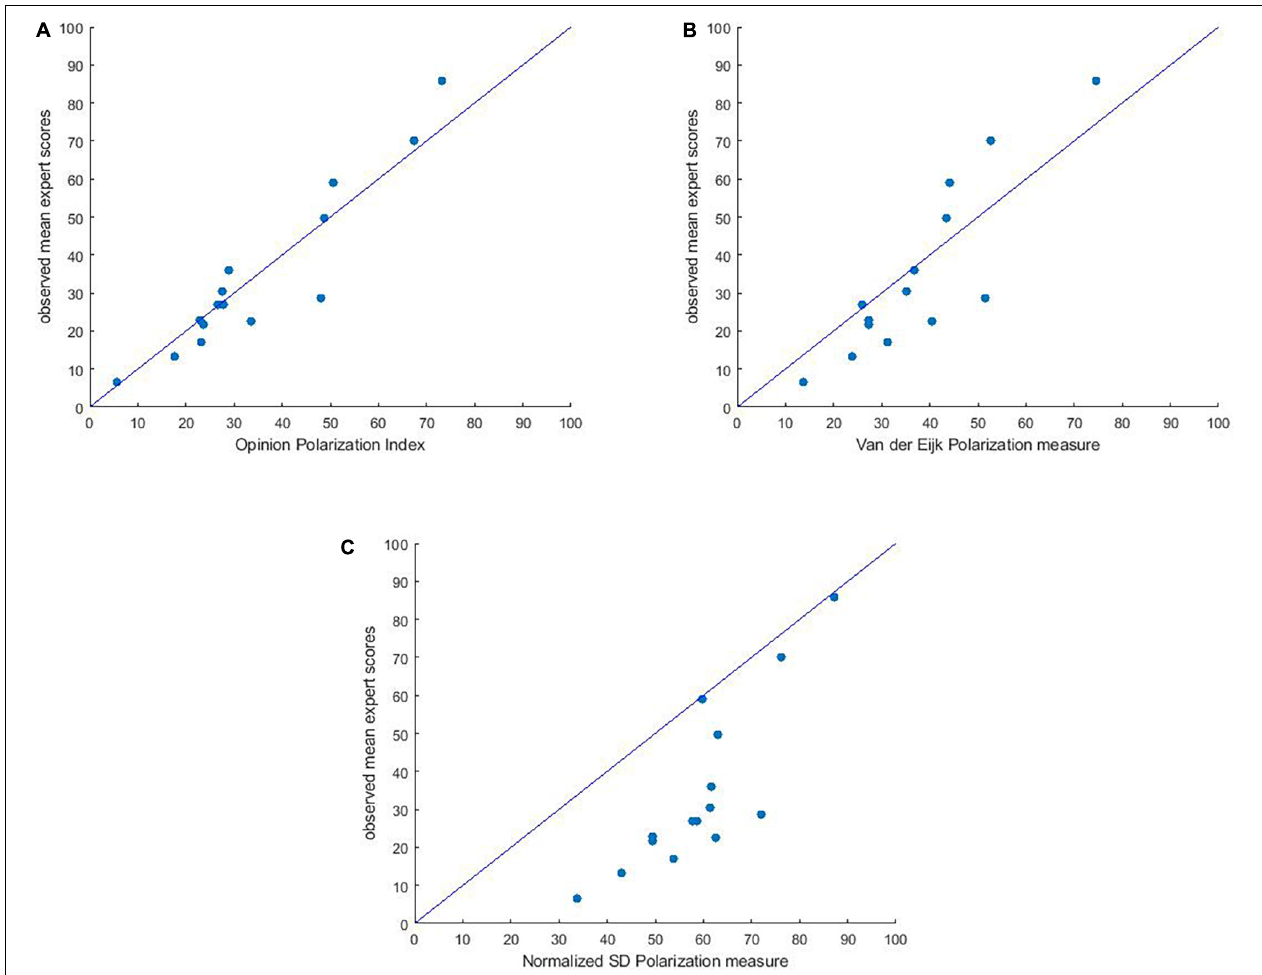
FIGURE 2 | (A) Observed mean judgment scores for the 15 distributions plotted against the polarization values predicted by the Opinion Polarization Index, according to P = 1.07 × f 2 b + 1.35 × f 3 + 1.98 × f 4 . (B) Plot of mean expert polarization scores against the normalized standard deviation values for all 15 distributions. (C) Plot of mean expert polarization scores against Van der Eijk’s measure for all 15